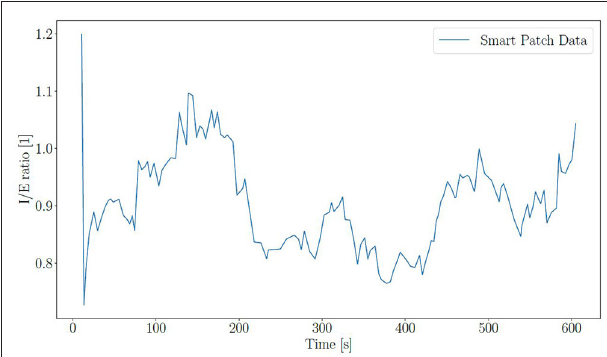
take deep and slow breaths compared to people who take shallow and fast breaths.